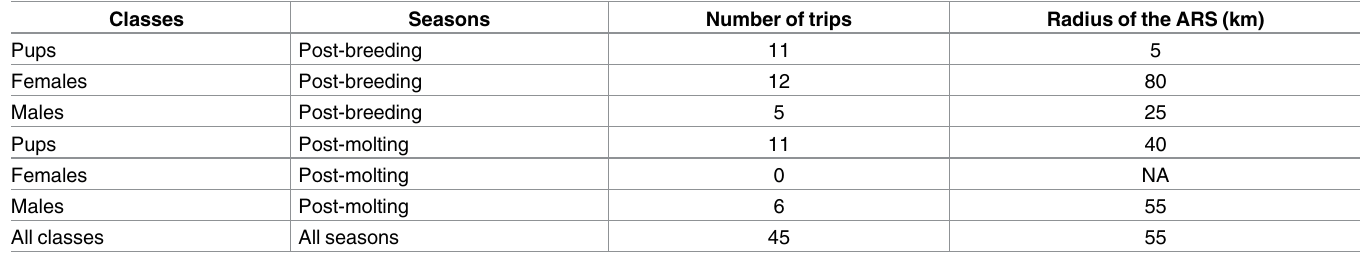
Table 3. Area restrictedsearch (ARS) scale for each age/sex class per